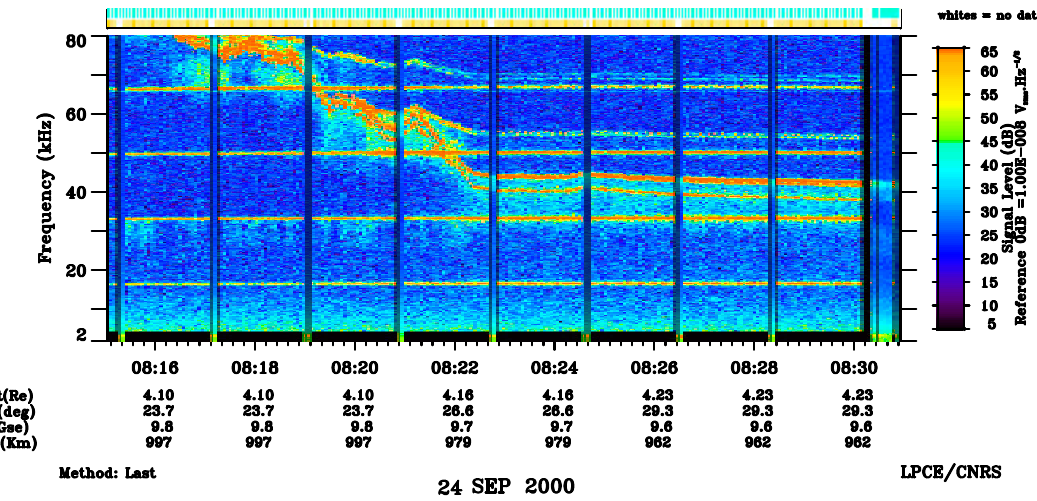
Fig. 1. Dynamic spectrogram of the electric field spectral densities observed by Whisper on 24 September 2000 from Cluster 2 Salsa. The instrument was in active mode for most of the period displayed. The strong horizontal lines are resonances at the harmonic of the local electron gyrofrequency. Resonances at Fp , Fuh and Fq seen at decreasing frequencies until 08:22UT are evident between the